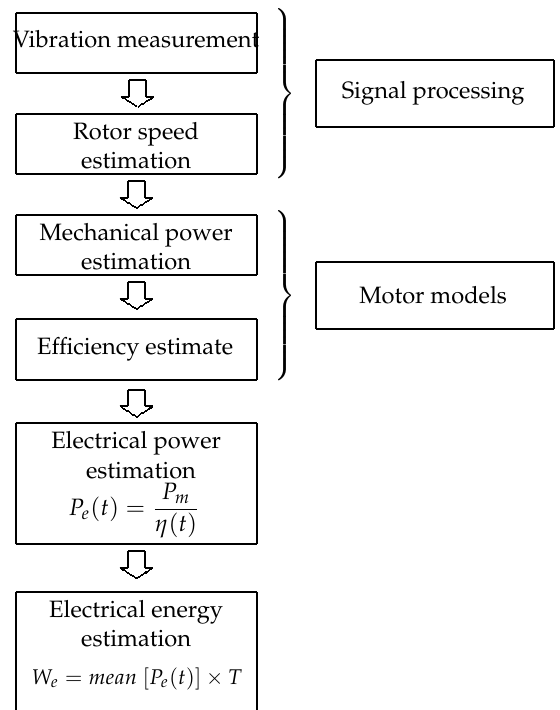
Figure 1. Principle of electrical energy